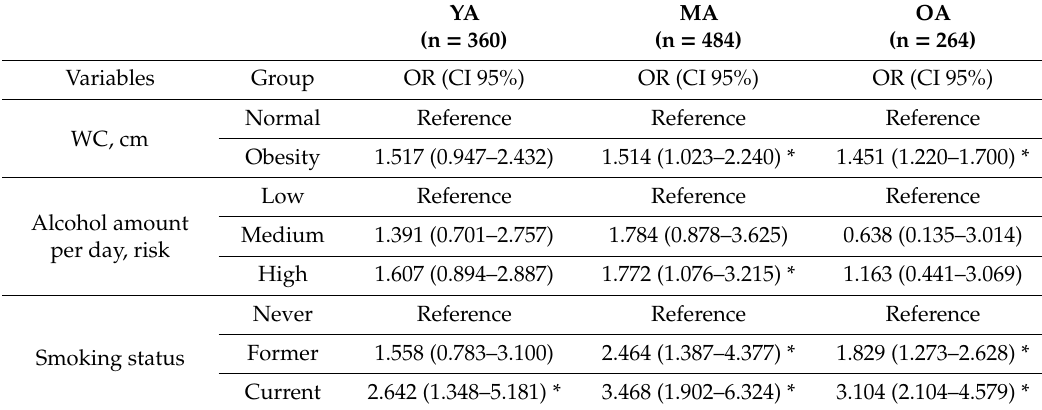
Table 3. Colorectal polyp and health behavior (polyp number 0 vs. ≥